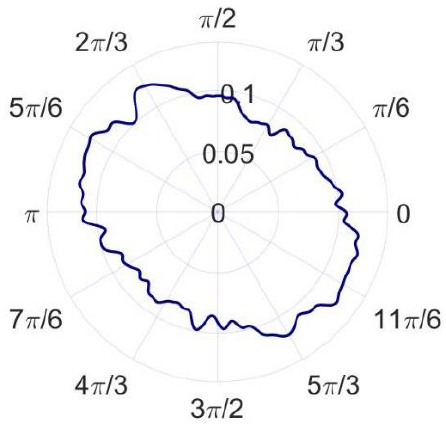
Figure 14. Radial error of the spindle.